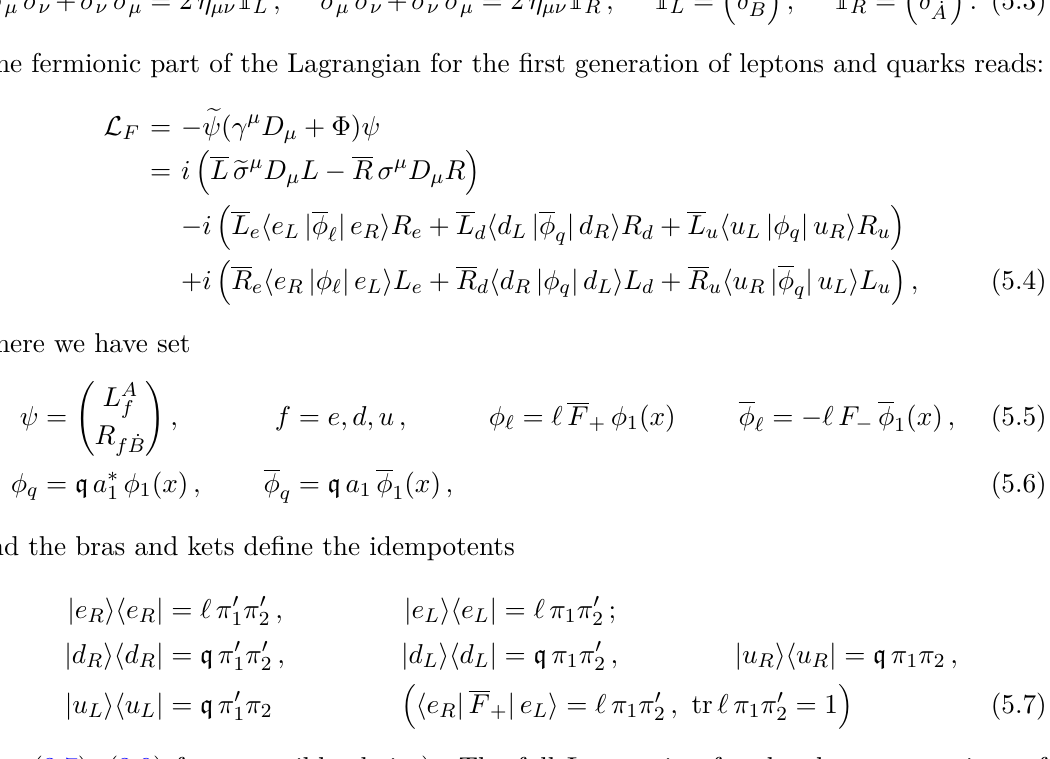
β = − βγ where the star stands for her- µ µ ⊗ 1 , γ = − σ ⊗ σ corre- 1 2 j 2 j (defined to obey t γ C = − Cγ , for t γ trans- 2 µ µ µ (= σ A ˙ B ) , σ = ( σ ) , A, B, ˙ A, ˙ B = 1 , µ µ e e µ µ ˙ AB